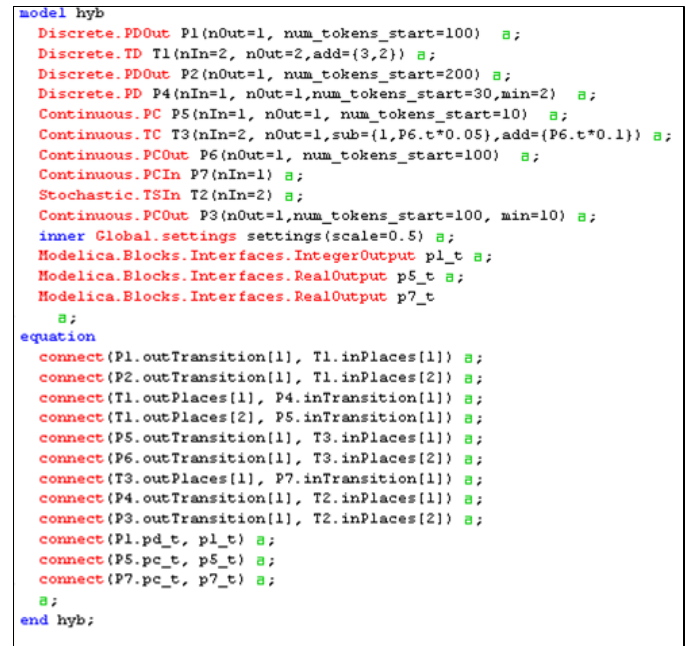
Figure 16: Textual Modeling of Petri Nets in